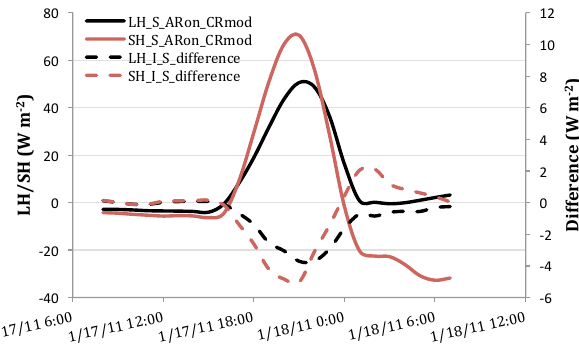
Figure 13. Area average of latent heat flux (LH) and sensible heat flux (SH) over the Central Valley in S_ARon_CRmod and the av- erage difference between I_ARon_CRmod and S_ARon_CRmod from 08:00UTC on 17 January (0Z local time) to 07:00UTC on 18 January (23Z local